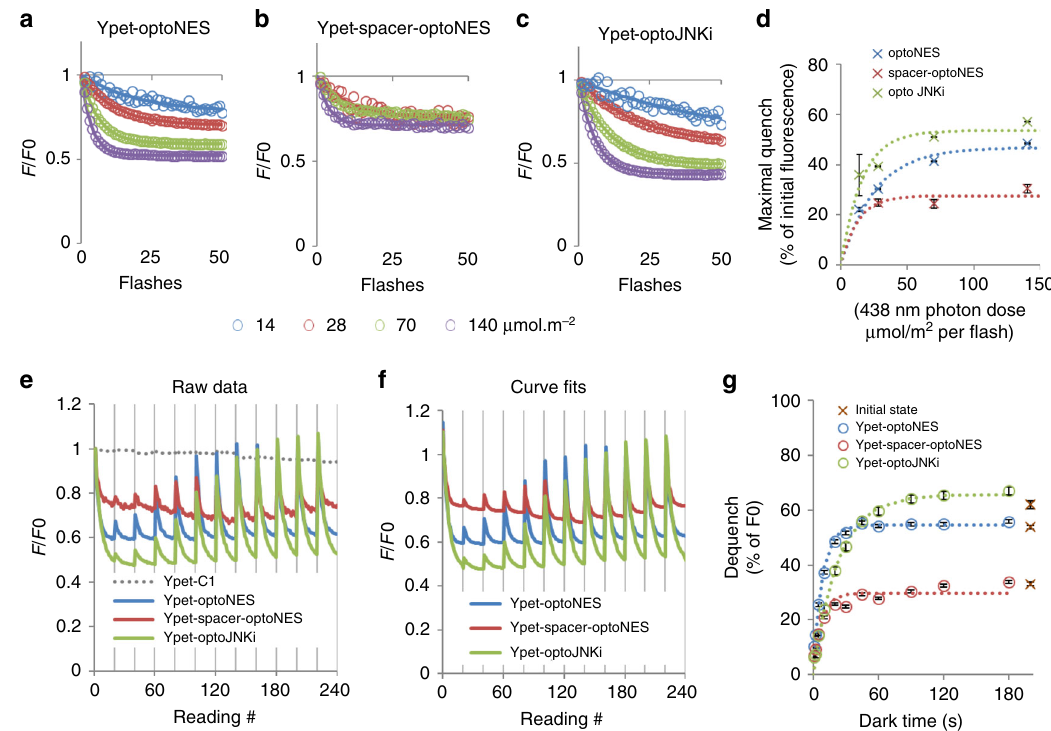
Fig. 6 Activation rates and dark state relaxation rates of LOV2-based actuators fused to Ypet. a Fluorescence emission of Ypet-optoNES, detected through a 542/26nm fi lter, on excitation pulses with 14 – 140 µ mol m − 2 of 438 nm excitation light (as Fig. 3) shows reducing intensity or quenching at a rate depending on the photon dose. This is consistent with a FRET from LOV2* to Ypet that is diminished as LOV2-390 is formed. Note 5x more light is used here than for mTq2 fusions. Similar results are obtained with b Ypet-spacer-optoNES and c Ypet-optoJNKi. Means ( n = 3) are shown. d shows the best- fi t maximal quench increases (±S.E., n = 3 wells) with illumination intensity increases, allowing a quench limit to be estimated by fi tting to a single site model (dotted line). Quench limits, activation rate constants and relaxation time constants during illumination for the Ypet constructs, and corresponding data from mScarlet constructs, are shown in Supplementary Fig. 13, indicating FRET from LOV2 to the fl uorescent tags in all cases and to a reduced extent in the spacer construct (the Ypet-spacer construct with limited energy transfer was too dim for parameter estimation). e The constructs (means of n = 3 wells shown) were subjected to cycles of activation and darkness as in Fig. 4 and fl uorescence (438 nm excitation, 500 nm emission, corrected to control Ypet-C1 signal shown as dotted line) measured and f fi tted to repeated exponential decays with a common time constants for each construct in each experiment; g The best- fi t dequench ± S.E. from f is plotted against the preceding dark time and fi tted to an exponential to derive a relaxation time in darkness. The best- fi t parameters — max. quench at 140 µ mol m − 2 photons, apparent activation during concurrent relaxation and relaxation time during darkness — estimated from activation-relaxation cycles are listed for both Ypet and mScarlet fusions, together with derived parameters, in Table 1A. The quench limits and sensitivities are in general consistent with d and dark relaxation times are slightly slower than lit relaxation times, suggesting a contribution of photochemical back reaction in d . Source data are provided as a Source Data fi